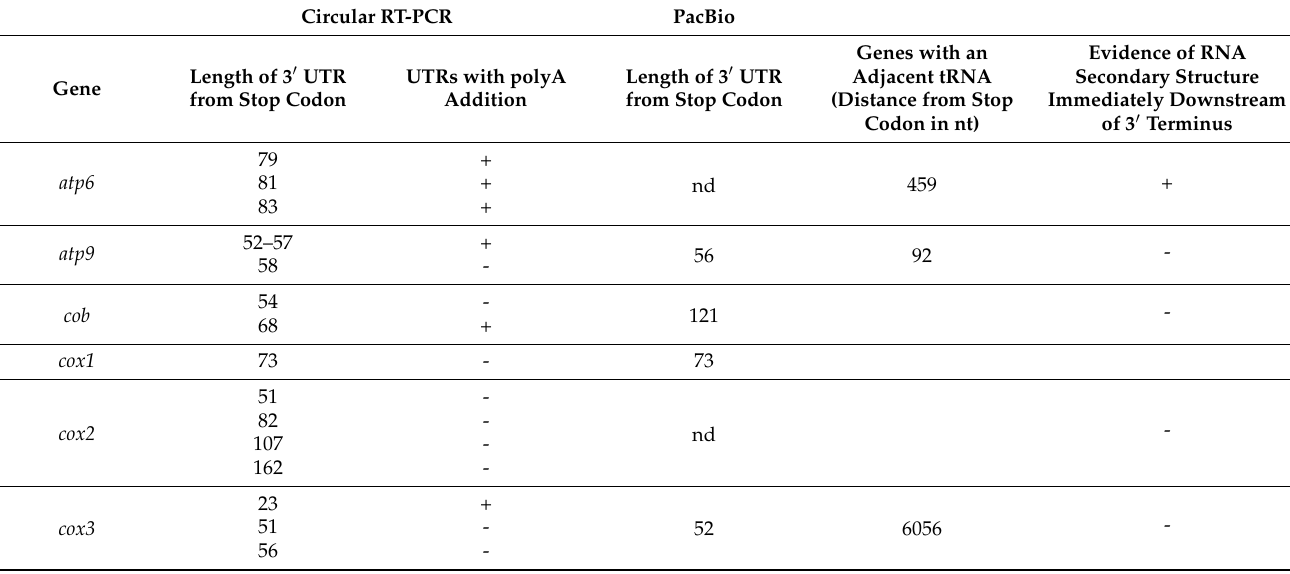
Table 4. Length of the most abundant 3 (cid:48) UTRs found in Chara vulgaris and those with a non-template polynucleotide addition. Circular RT-PCR